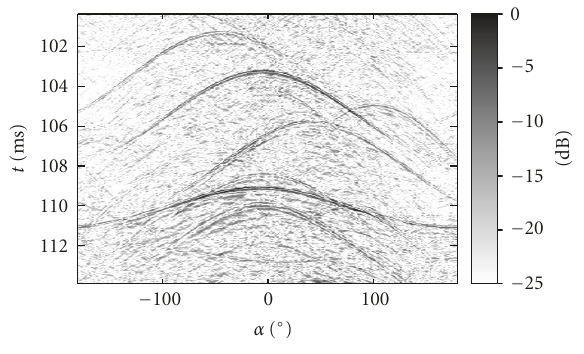
Figure 4: Multitrace impulse responses measured in the Frits Philips Concert Hall, Eindhoven, The